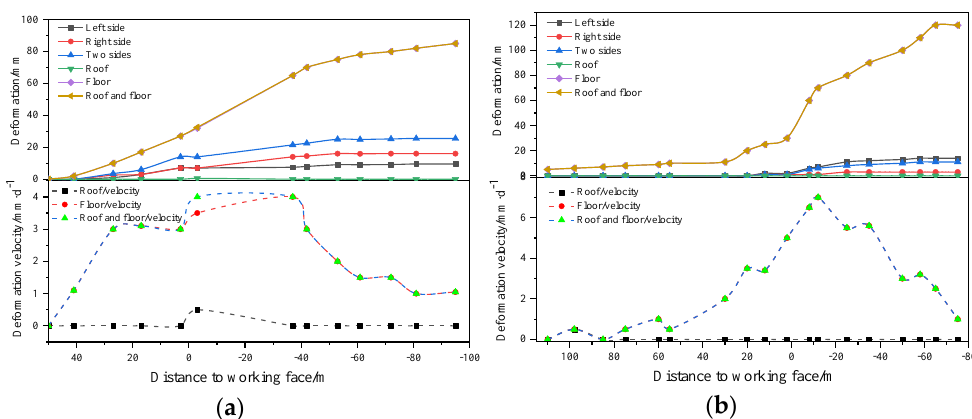
Figure 5. Comparison of deformation amount and deformation velocity of roadway surrounding rock ( a ) measuring point 2# ( b ) measuring point 1#.